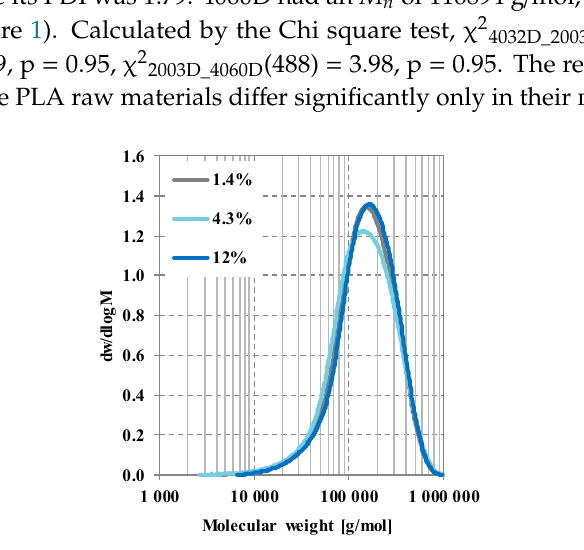
Figure 1. Molecular weight distribution of PLAs with different D -lactide content.